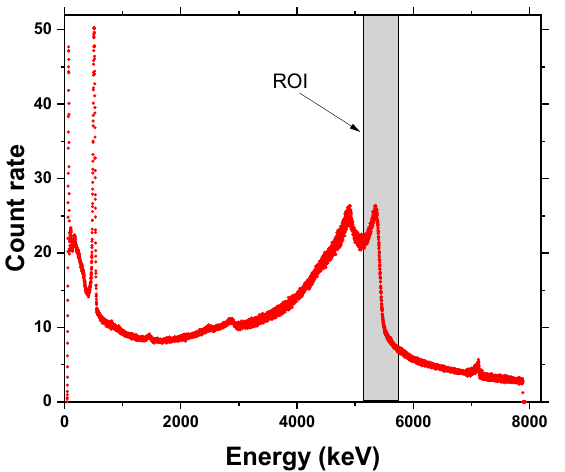
Figure 5. Typical LCS gamma ray spectrum obtained from the LaBr 3 (Ce) detector. The shaded area is the region of interest (ROI).